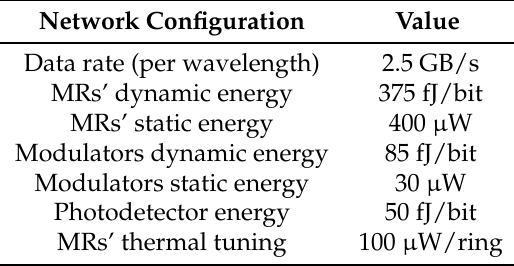
Table 3. Photonic communication network energy